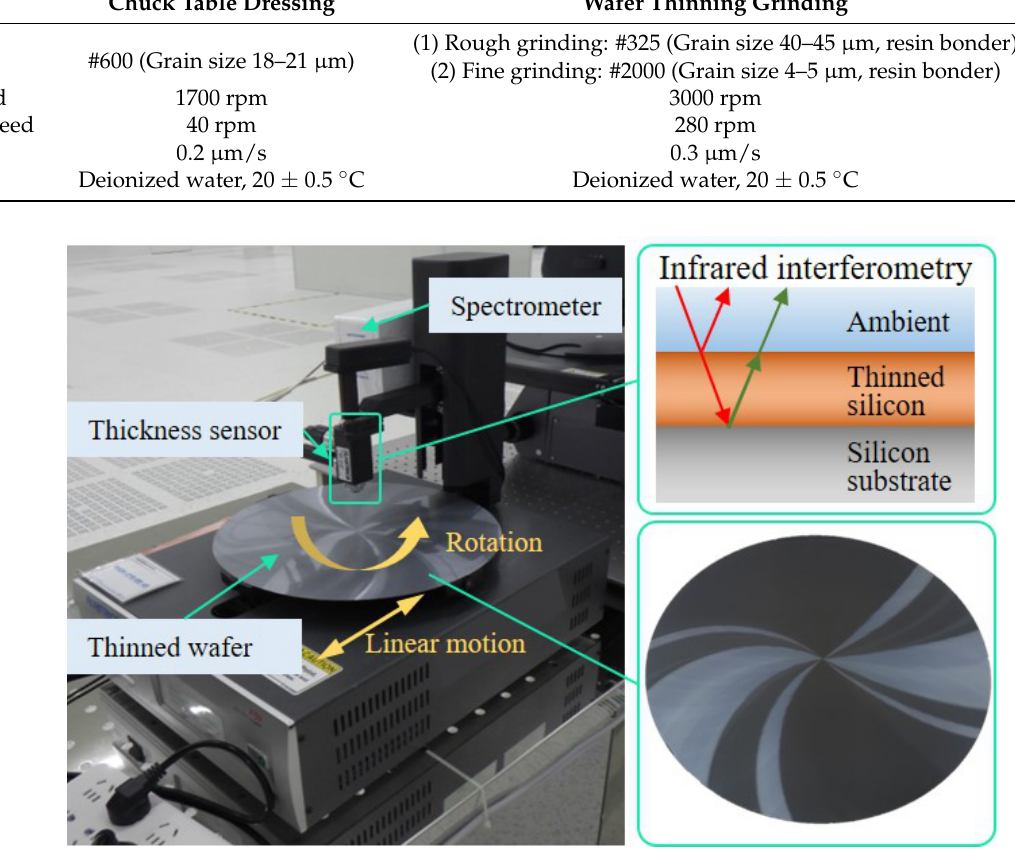
Figure 14. The device for wafer TTV measurement and its